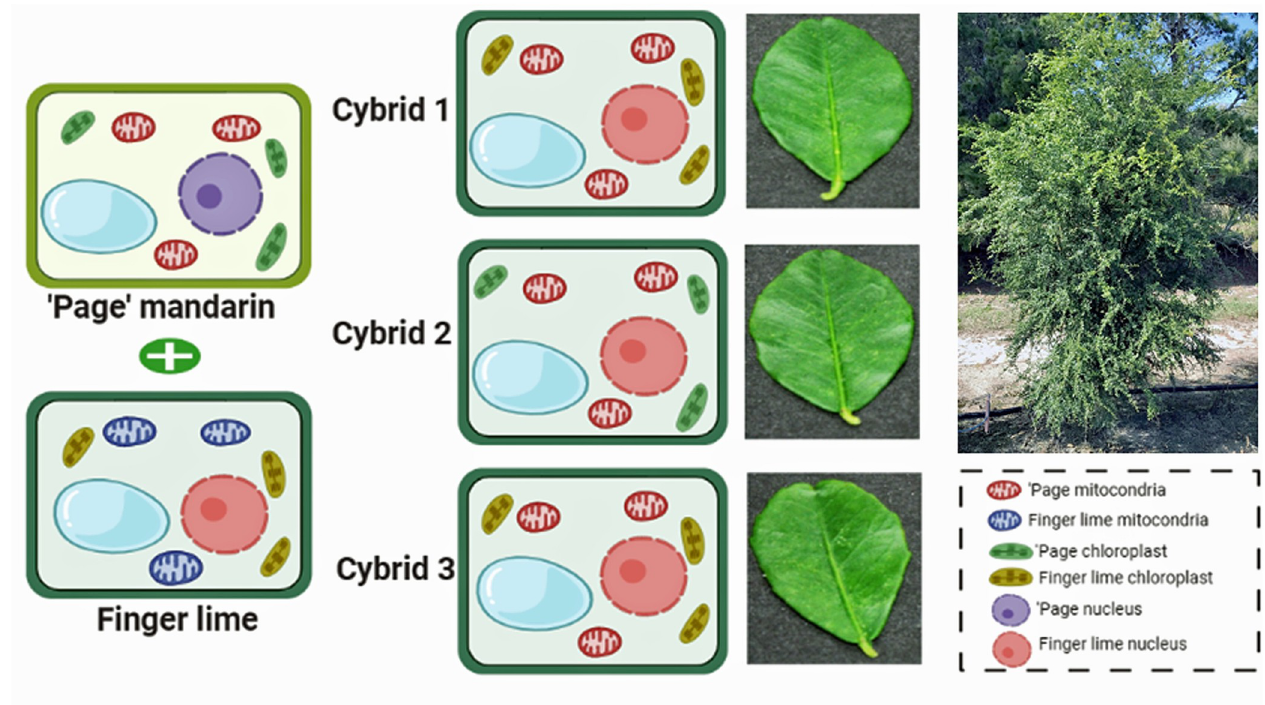
Fig 4. Schematic diagram showing nuclear and organelles inheritance of three cybrids through protoplast fusion. The cybrids plants are carrying the finger lime nuclear genotype. Two cybrids (1 and 3) inherited the finger lime plastids, while cybrid 2 inherited the ‘Page’ mandarin plastid genome. All finger lime cybrids inherited the ‘page’ mitochondrial genome. The top right tree represents one of the cybrids in the field. Figure was created in BioRender.com.